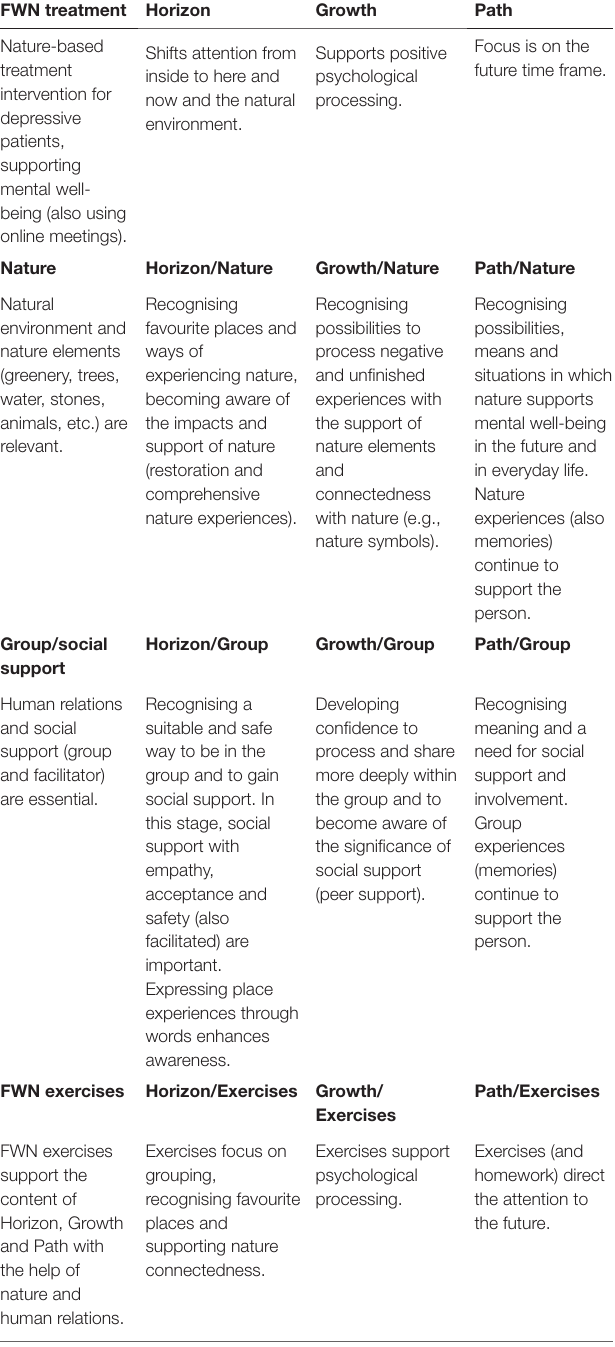
TABLE 1 | Separate stages of the Flow with Nature (FWN)